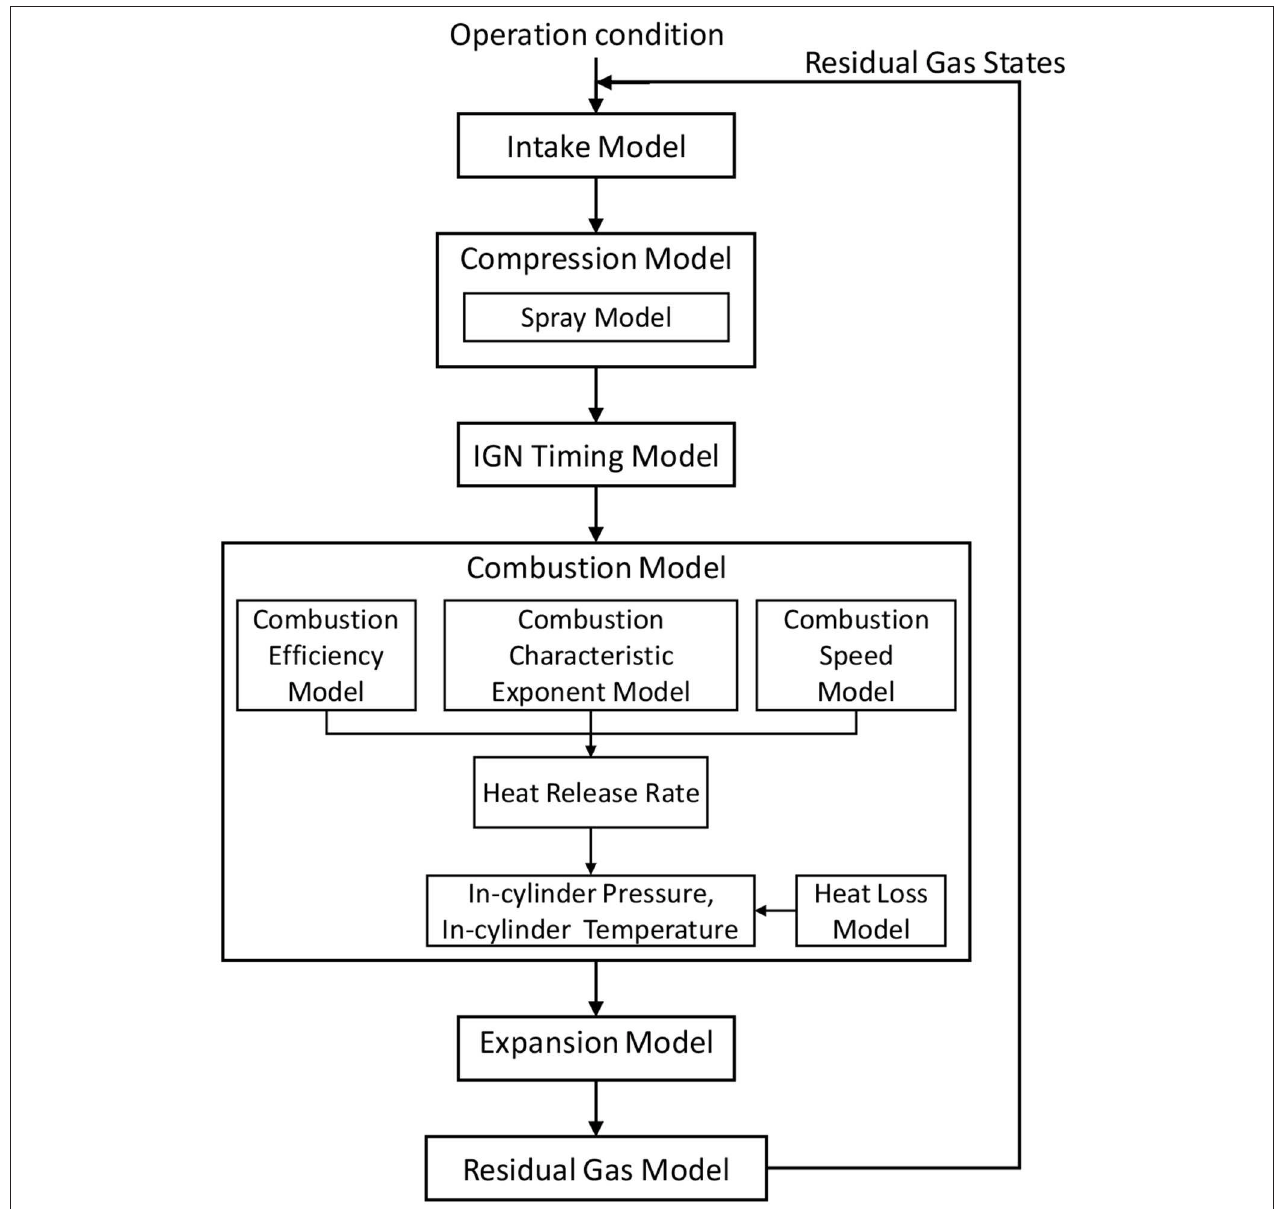
FIGURE 4 | Calculation flow of the DFE combustion control model.